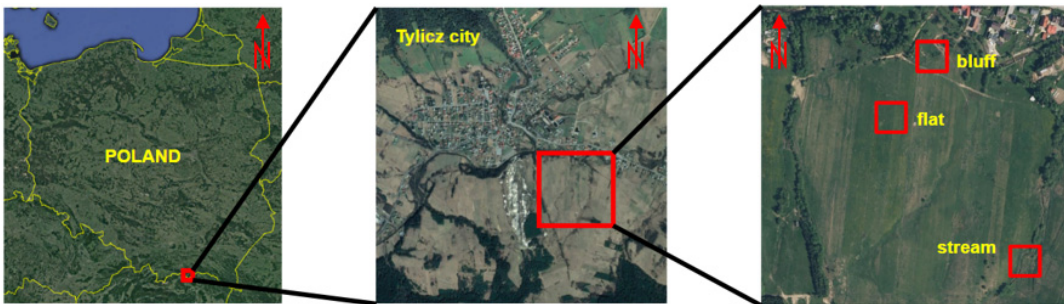
Figure 1. The location of the analyzed parts of the terrain.